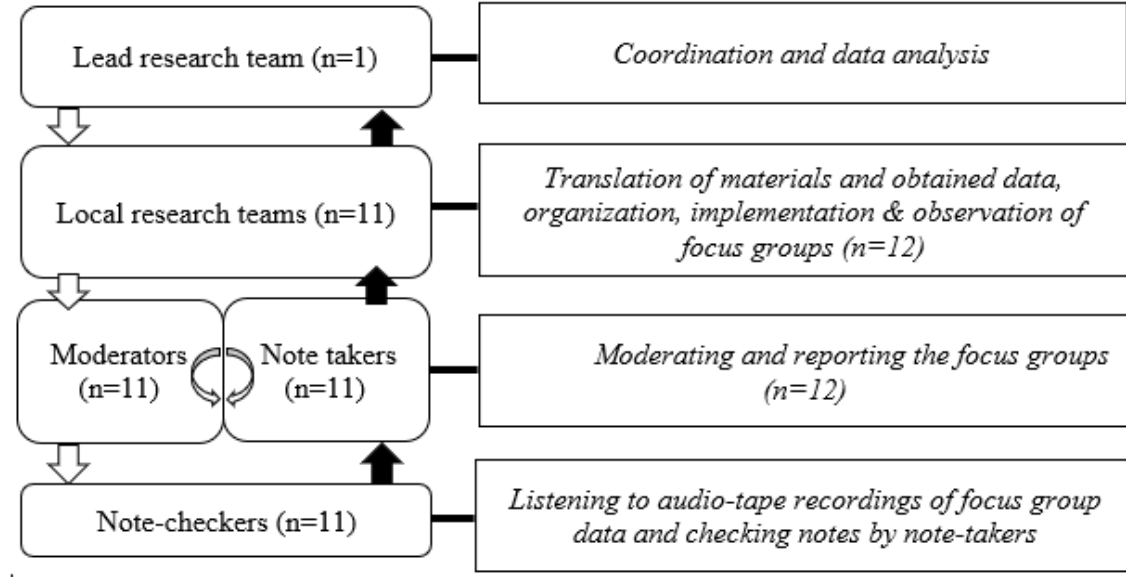
Figure 2. Procedures and roles regarding the focus group